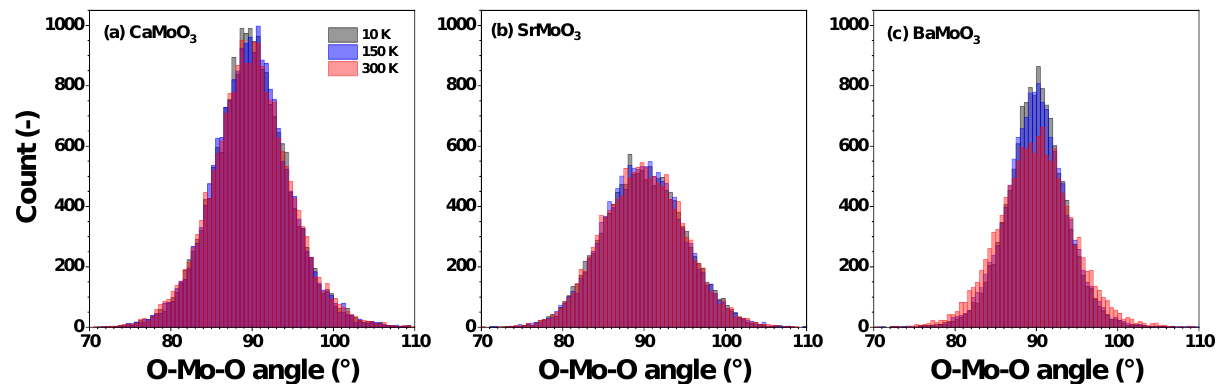
Figure 6. Histograms of intra-octahedral O–Mo–O angles—angular distribution functions (ADFs)— in polycrystalline ( a ) CaMoO 3 , ( b ) SrMoO 3 , and ( c ) BaMoO 3 at 10 K, 150 K, and 300 K. See text for details.